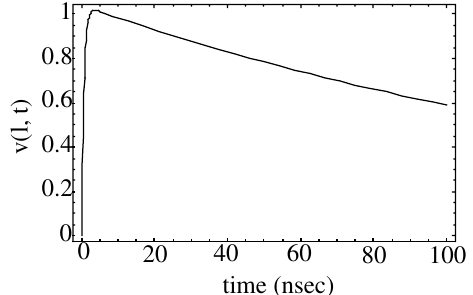
FIG. 2. Equivalent circuit of the induction unit.